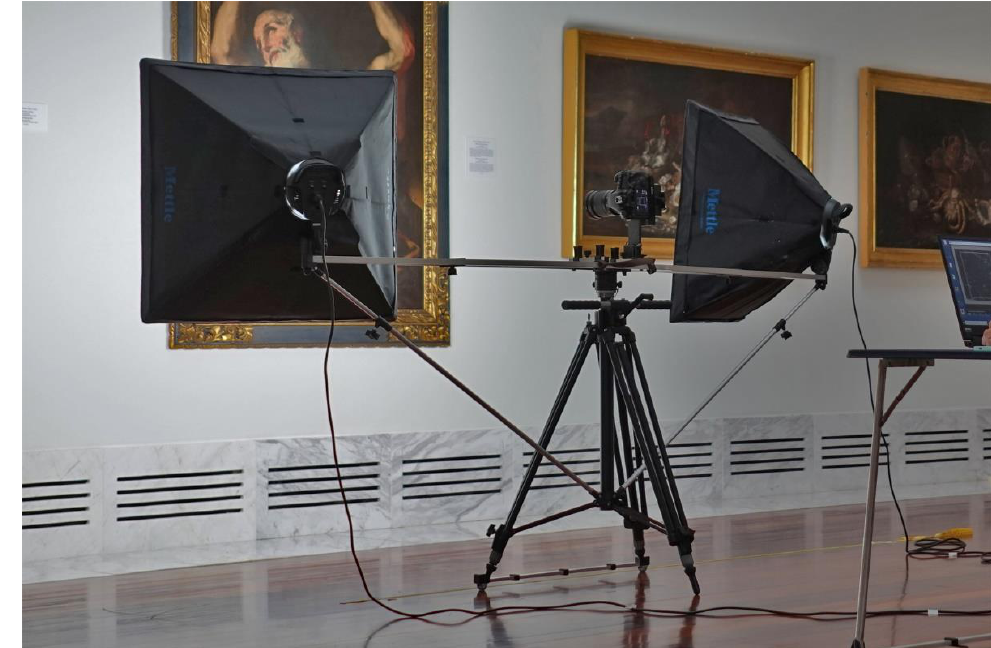
Figure 10. Lighting mount to attach the lighting system to the tripod.